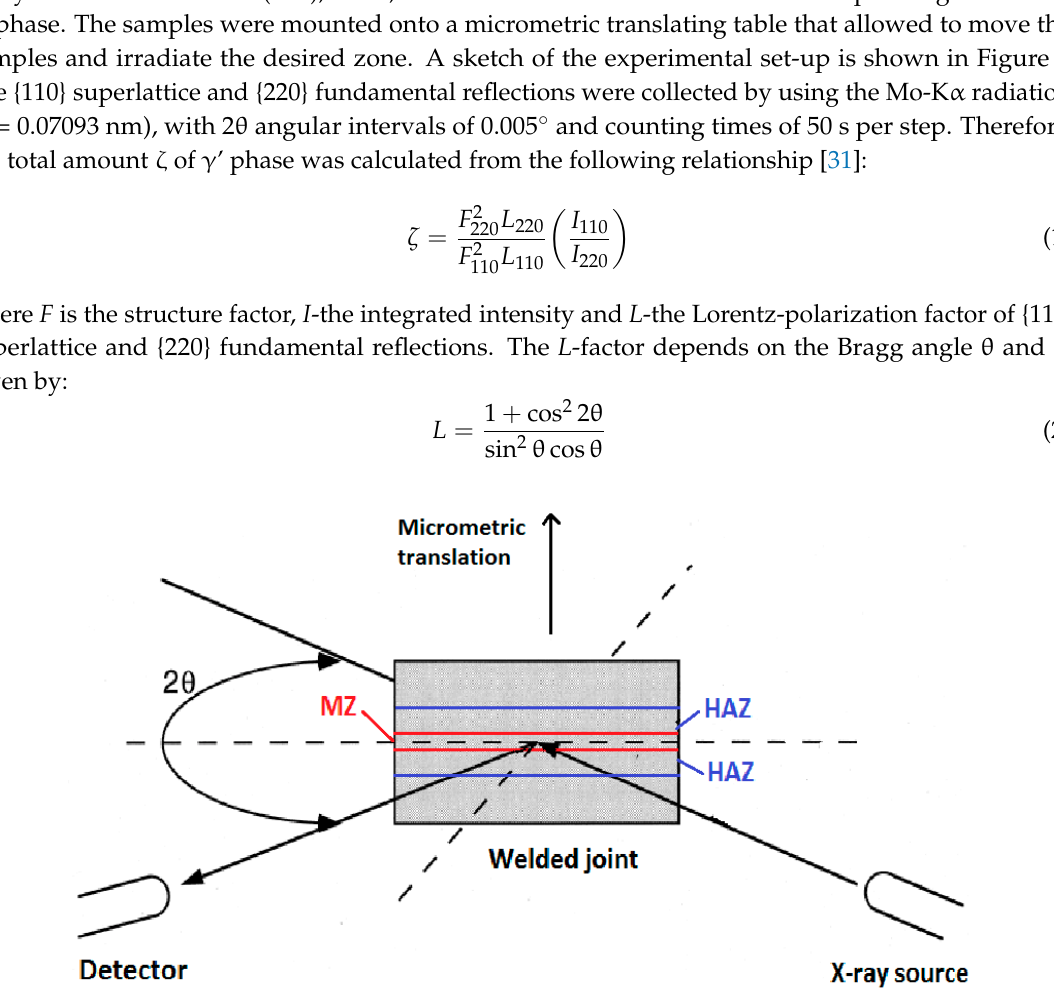
Figure 2. Experimental set-up used for focusing the X-ray beam on base metal (BM), heat affected zone (HAZ) and molten zone (MZ) of the joints.